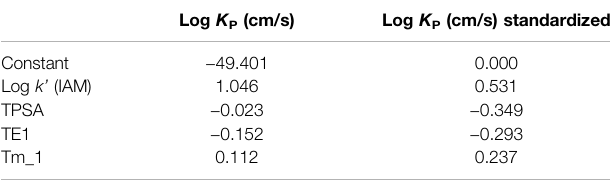
TABLE 4 | PLS-1 skin permeability regression coef fi